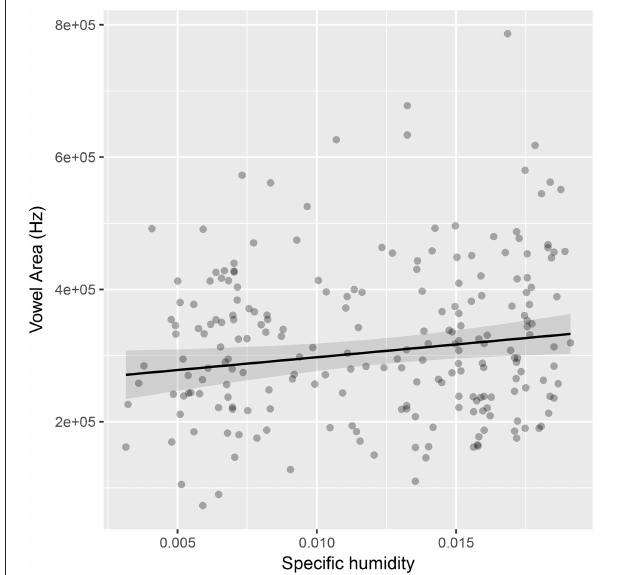
FIGURE 6 | The relationship between the range of frequencies a vowel space covers and the specific humidity in which it is used. The regression line is drawn according to the mixed effects model